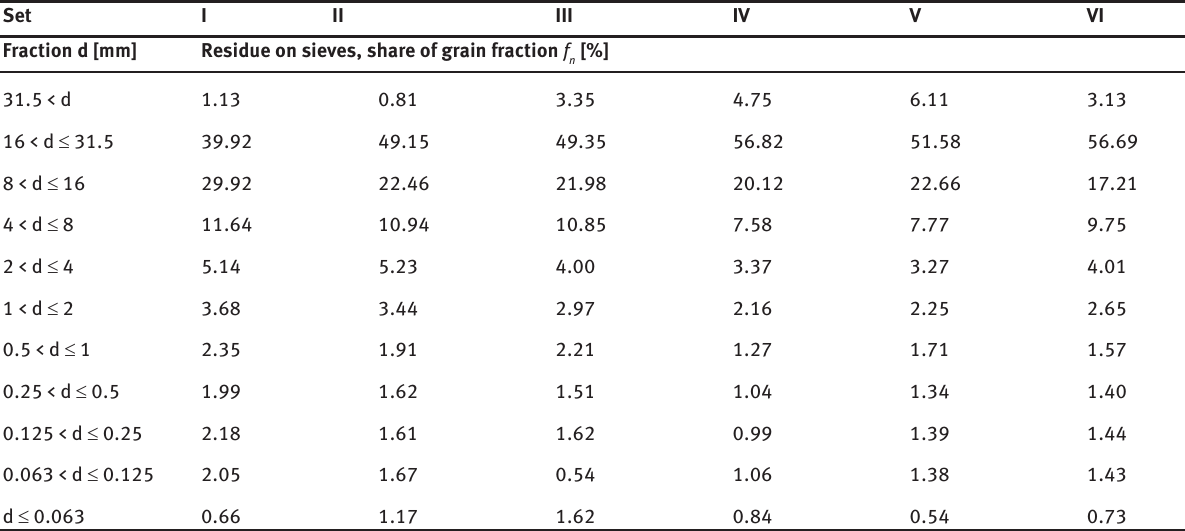
Figure 15: Scheme of measurement of the outlet slot e Table 2: Product particle size distribution for 6 sets of crushing plates Set I II III IV V VI Fraction d [mm] Residue on sieves, share of grain fraction f